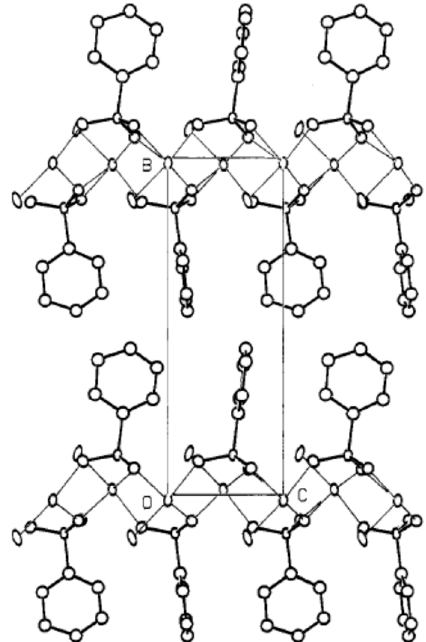
Figure 3. Structure of Mn(O 3 PC 6 H 5 ) · H 2 O viewed down the a -axis. Reprinted with permission from reference [21]. Copyright 1988, American Chemical Society.